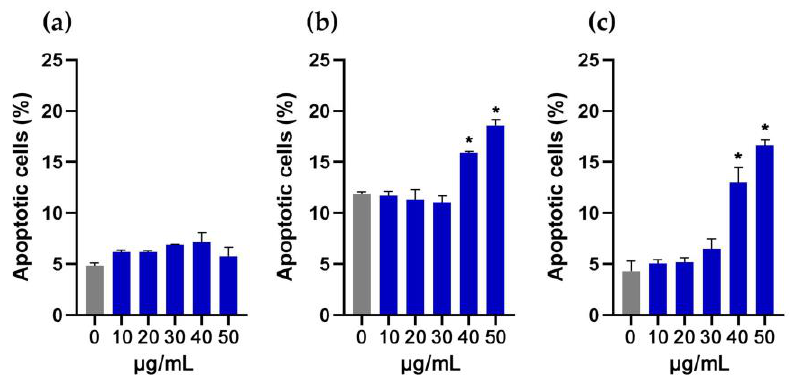
Figure 2. Percentage of apoptotic cell population after treatment with increasing doses of DMF for 24 h in NIH/3T3 ( a ), HaCaT ( b ) and THP-1 cells ( c ). DMF’s toxicity was tested at a range of 0.15% v / v to 0.75% v / v which is equal to treatment of 10 μg/mL to 50 μg/mL of cG. * Statistically significant difference from control ( p < 0.05).